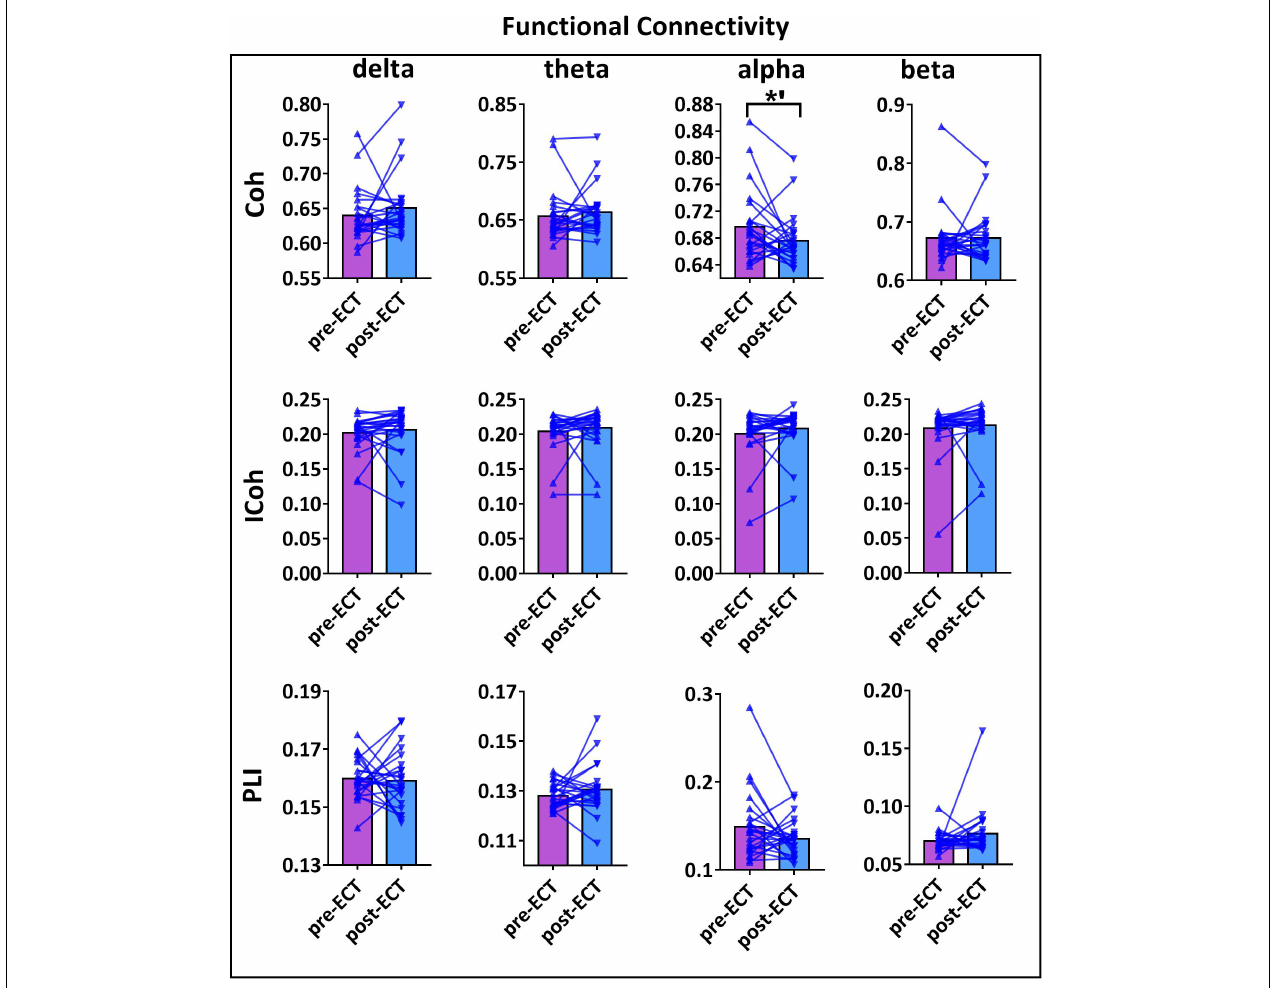
FIGURE 2 | The functional connectivity (FC) values of pre- and post-ECT patients with MDD obtained by three coupling methods [coherence (Coh), imaginary part of coherence (ICoh), and phase lag index (PLI)] in delta, theta, alpha, and beta frequency bands. The bar chart represents the mean values of FC in pre- and post-ECT treatments. The ∗ ’ represent marginally significant difference (0.05 < p < 0.1, pseudo-paired t -test based on permutation test, n = 10,000, p =